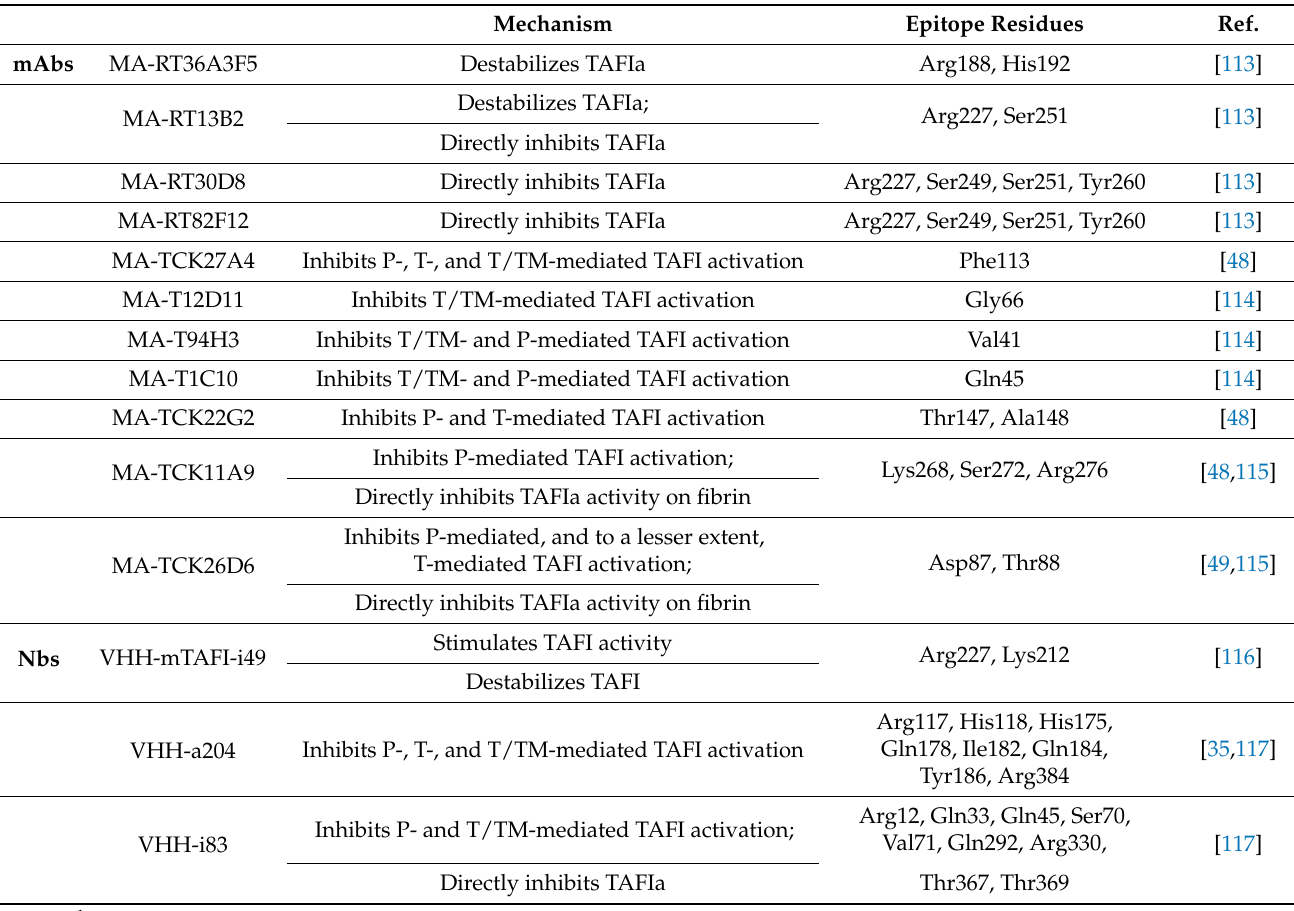
Table 2. Non-exhaustive list 1 of monoclonal antibodies (mAbs) and nanobodies (Nbs) that target TAFI or activated TAFI (TAFIa). Mechanism Epitope Residues